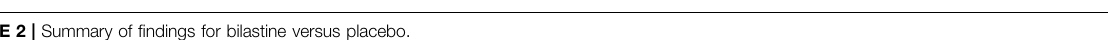
TABLE 2 | Summary of fi ndings for bilastine versus placebo. Bilastine versus placebo for allergic rhinitis Patient or population: Allergic rhinitis, intervention: Bilastine, comparison: